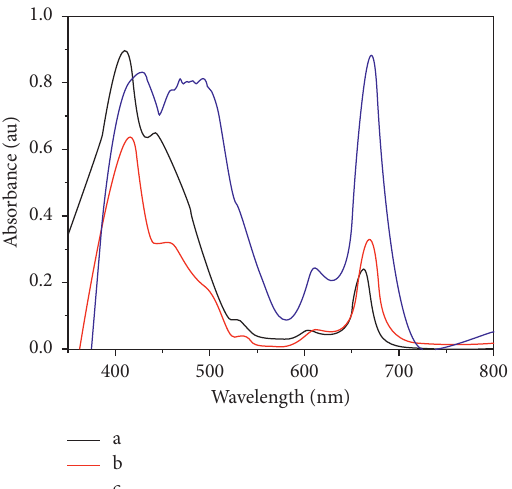
Figure 4: UV-Vis absorption spectra of the NA56 pigment extract (a) in ethanol, (b) on TiO